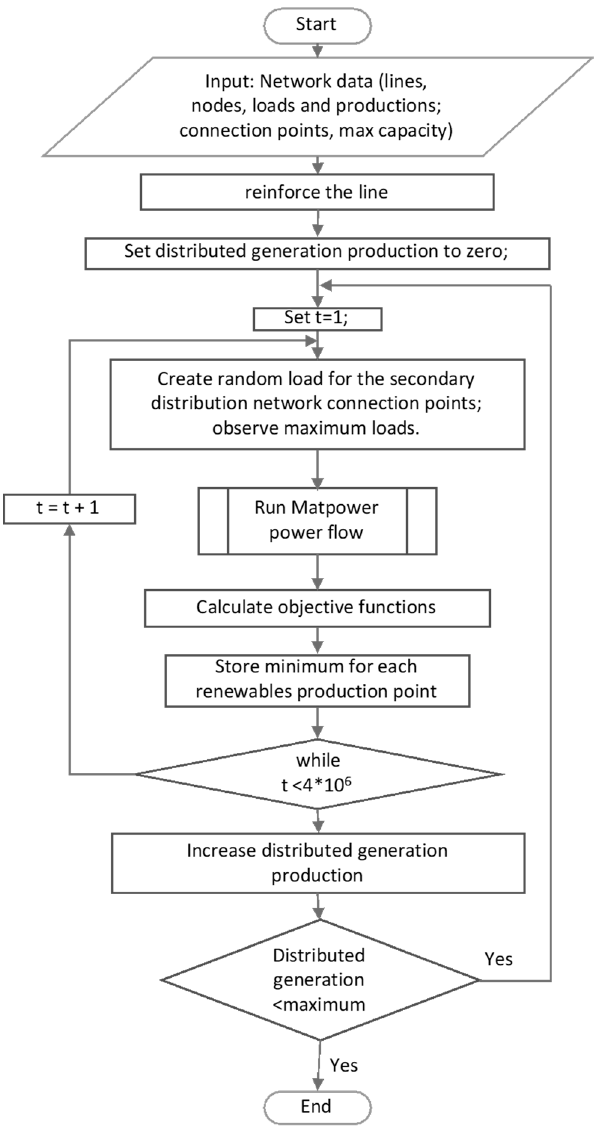
Figure 2. Flow chart of the developed calculation procedure.